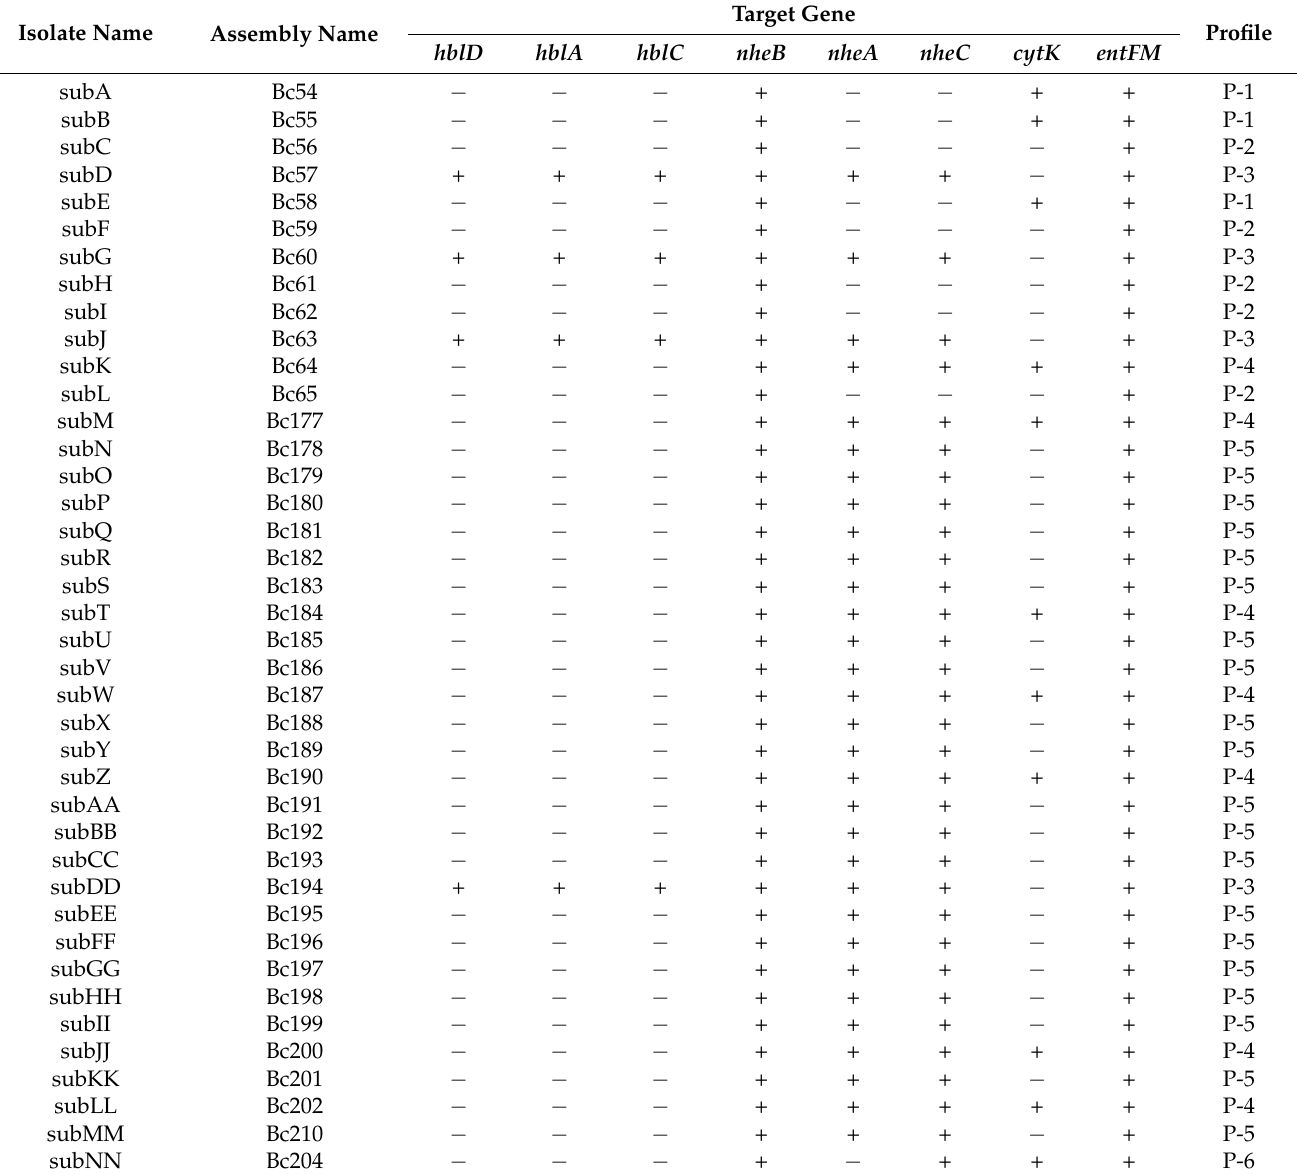
Table 2. Enterotoxin gene profiles of B. cereus strains isolated from baby wipes as identified using